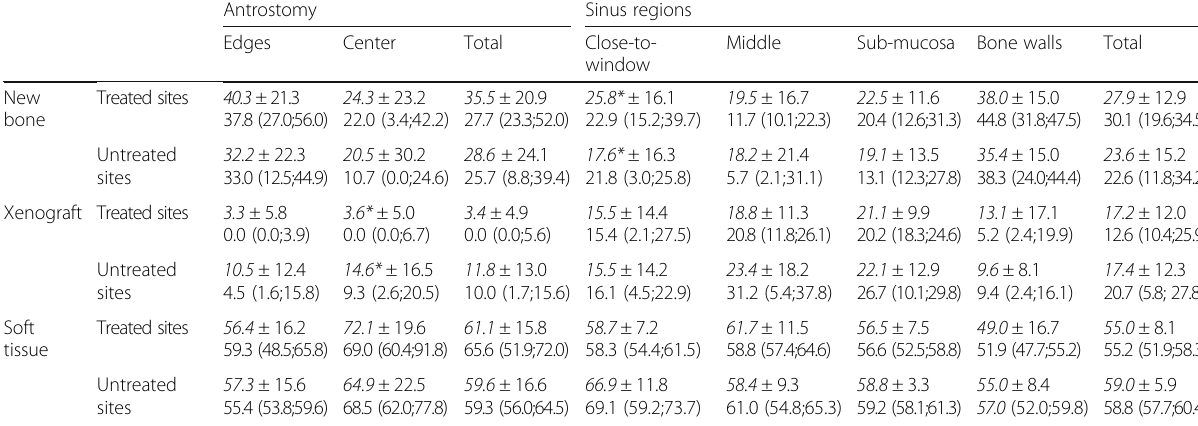
Table 2 Histomorphometric analysis. Tissues evaluated in the various regions after 8 weeks of